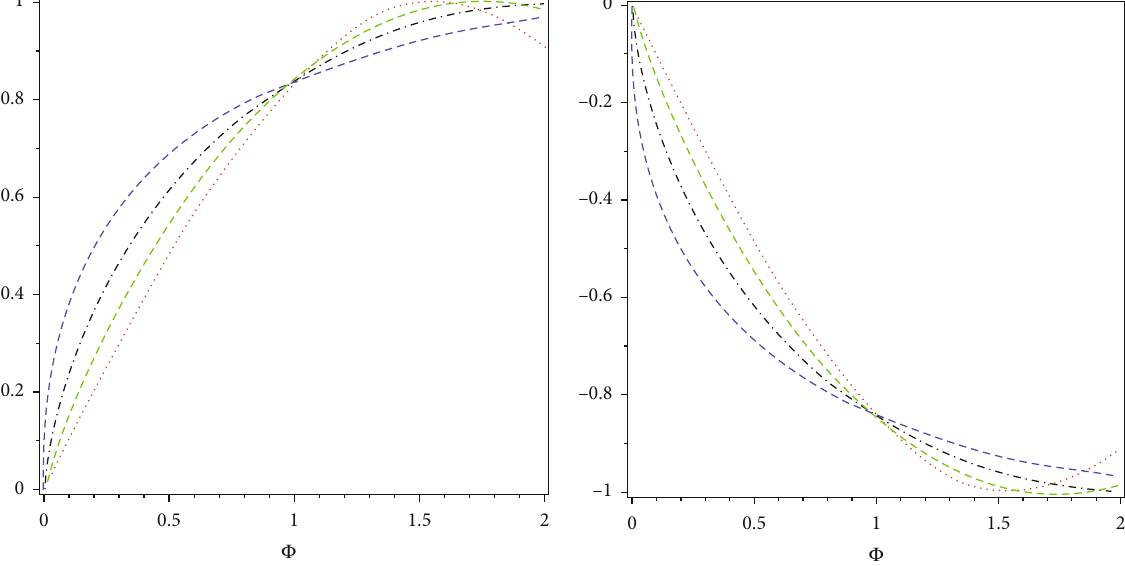
Figure 2: First two-dimensional fuzzy upper branch graph and second bottom branch graph of an analytic series result of various fractional of ρ with respect to